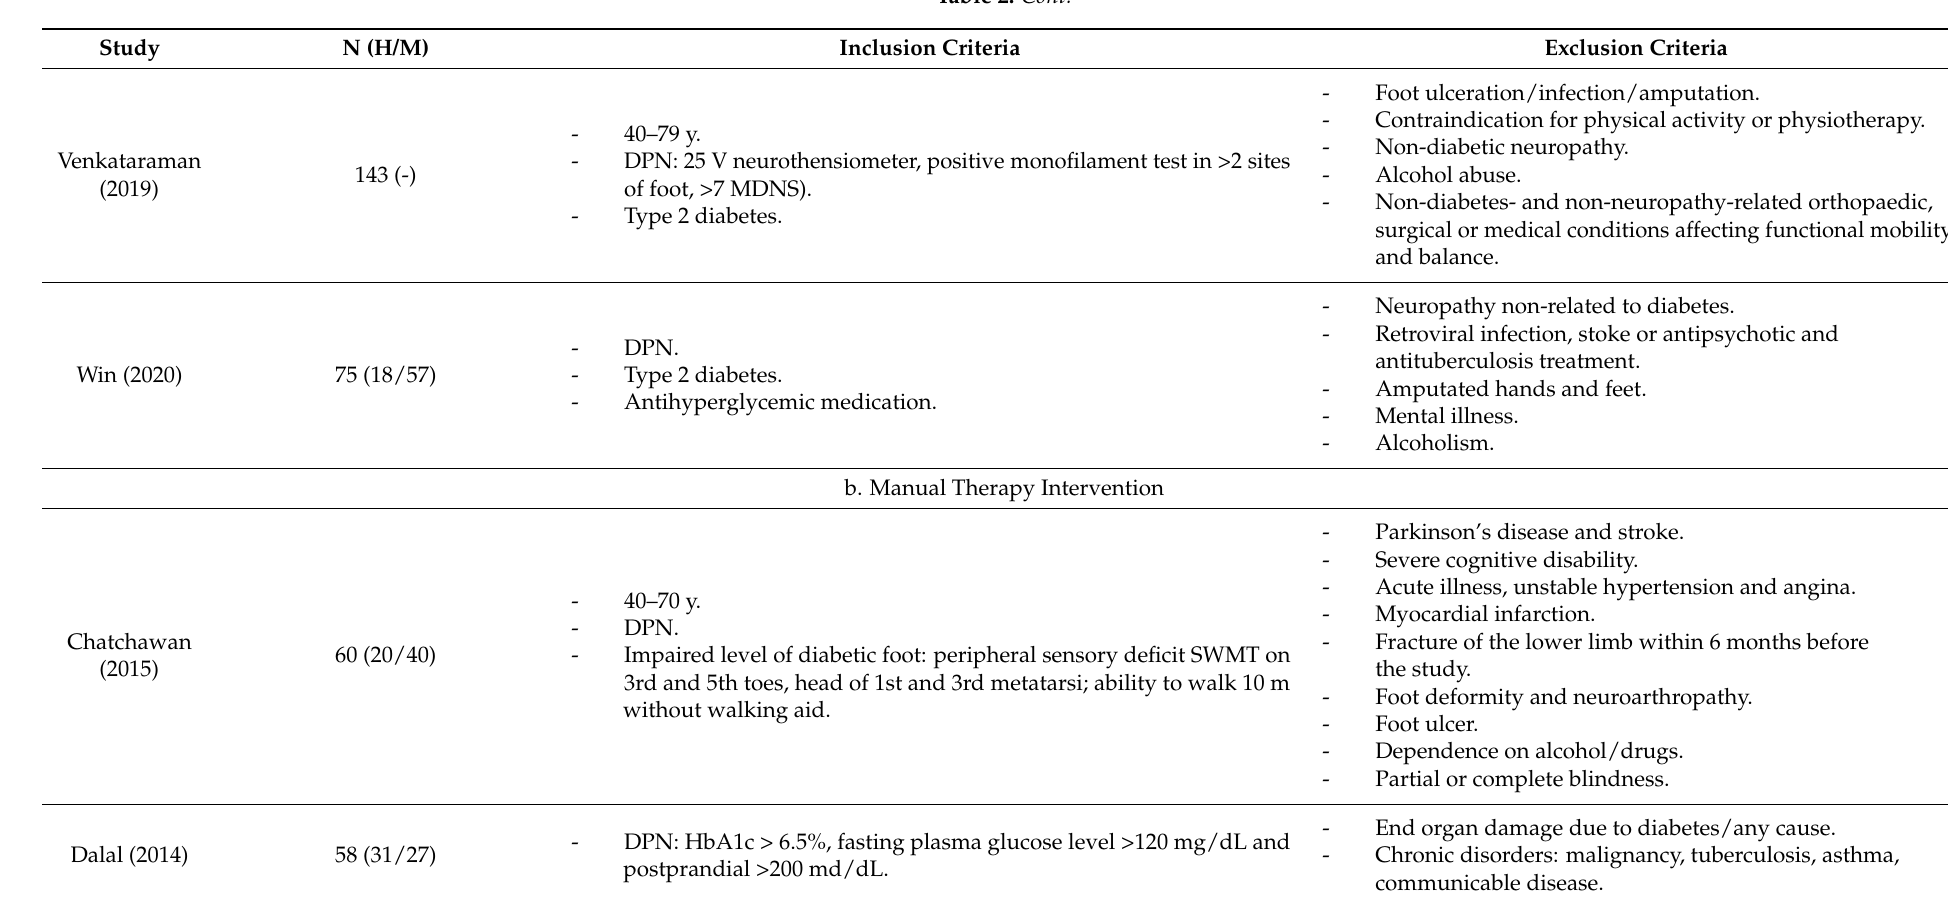
b. Manual Therapy